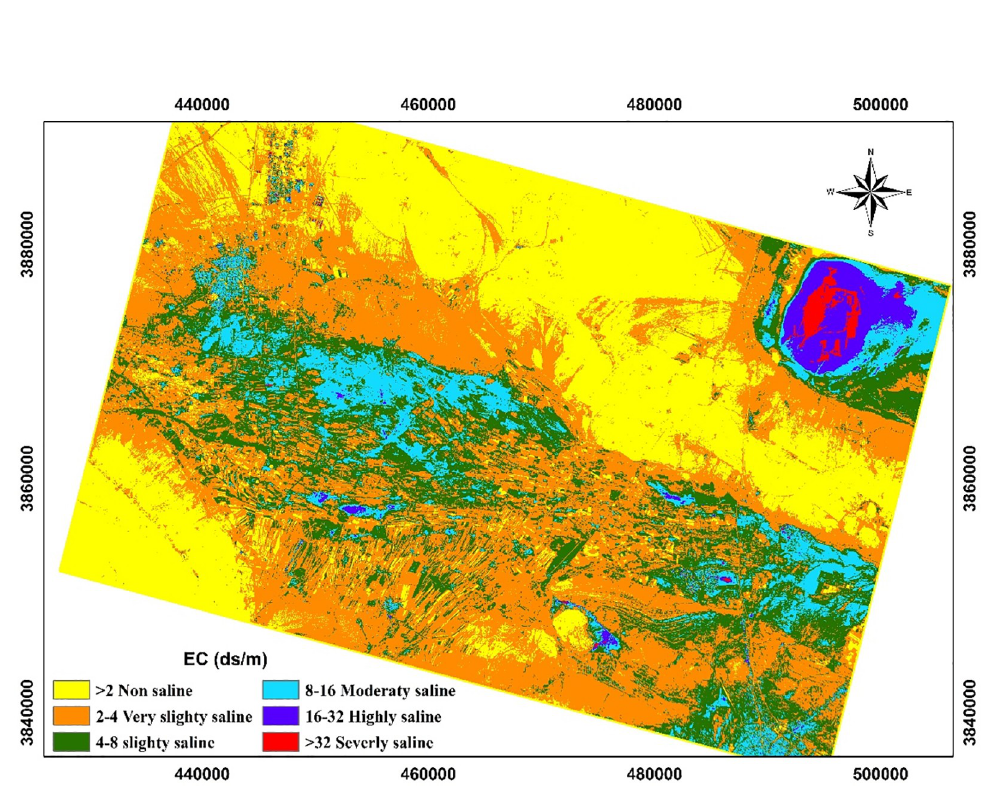
Fig 5. Soil salinity map of the study area using an artificial neural network, as can be seen, the highest salinity level found in the Hoze-Soltan playa in the northeast of the study area.